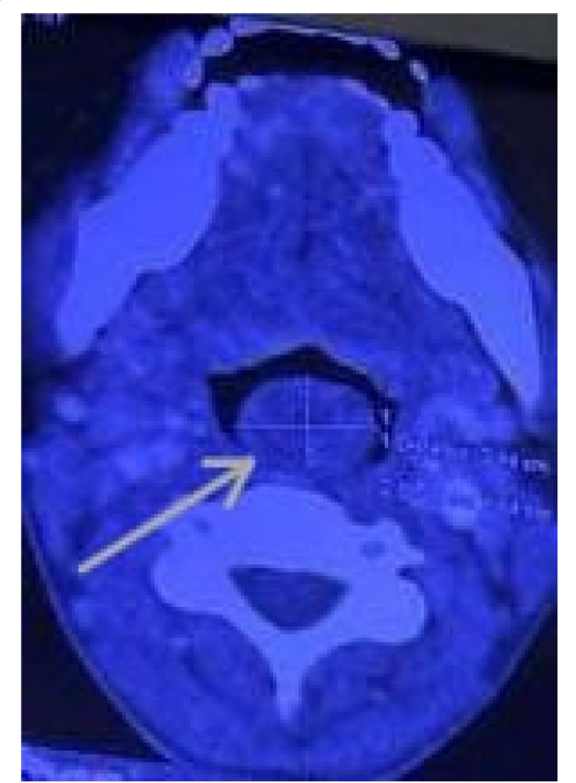
Fig. 2 CECT neck (Axial cut) showing mass arising from left tonsillar fossa with